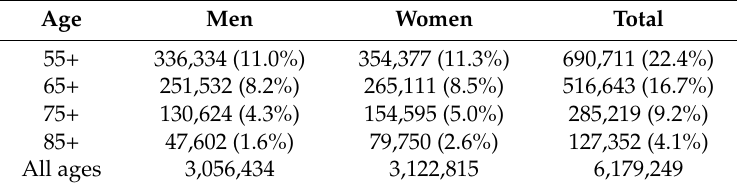
Table 1. Population of people aged 55 years and over in Victoria [1].